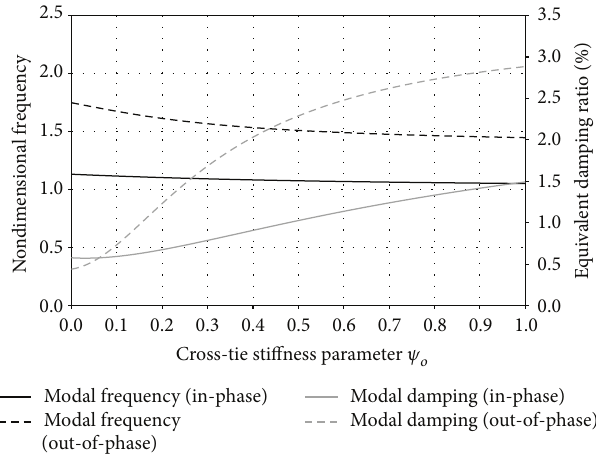
Figure 6: Effect of undamped cross-tie stiffness parameter 𝜓 𝑜 on modal frequency and modal damping ratio of the lowest in- phase and out-of-phase global modes of an asymmetric DMT cable network.